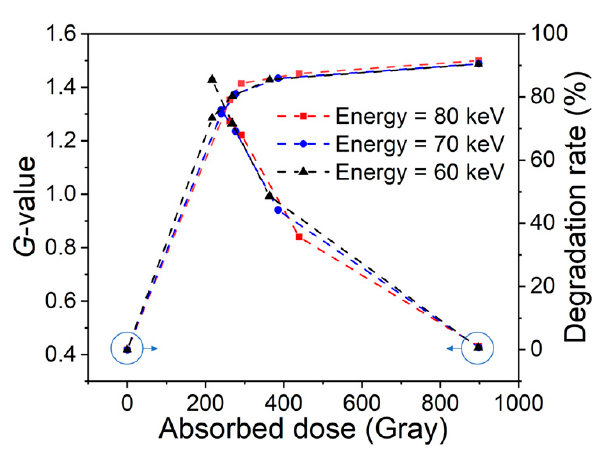
Figure 6. Effect of irradiation energy on degradation of SMZ (beam current = 1 mA; initial SMZ = 10.70 mg/L; pH = 12) .